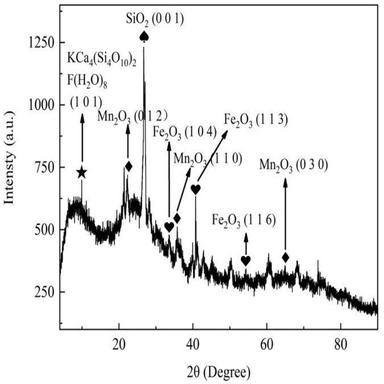
XRD patterns of waste coal cinder.